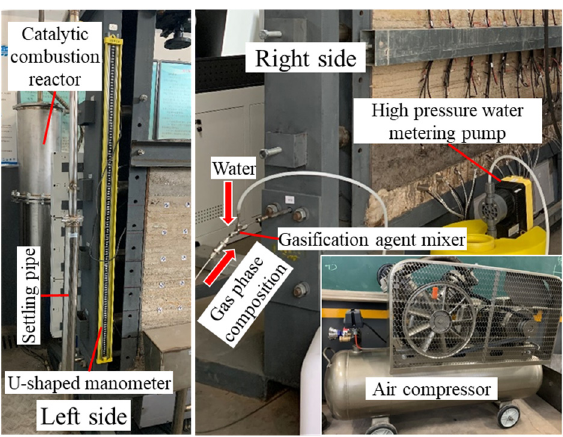
Figure 4. Gasification agent injection and produced gas discharge system.